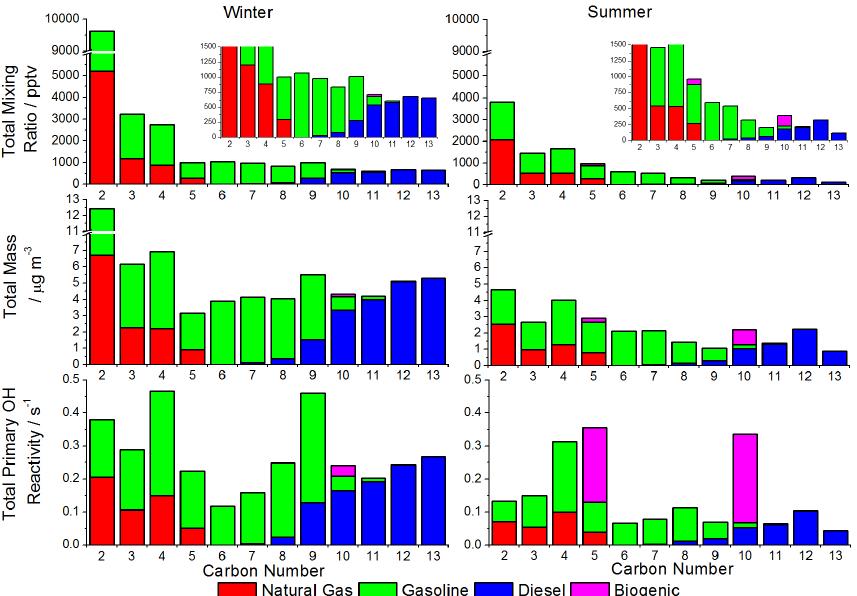
Figure 4. Seasonal median values for hydrocarbon mixing ratio, mass concentration and primary hydrocarbon OH reactivity in London air grouped by carbon number and potential emission